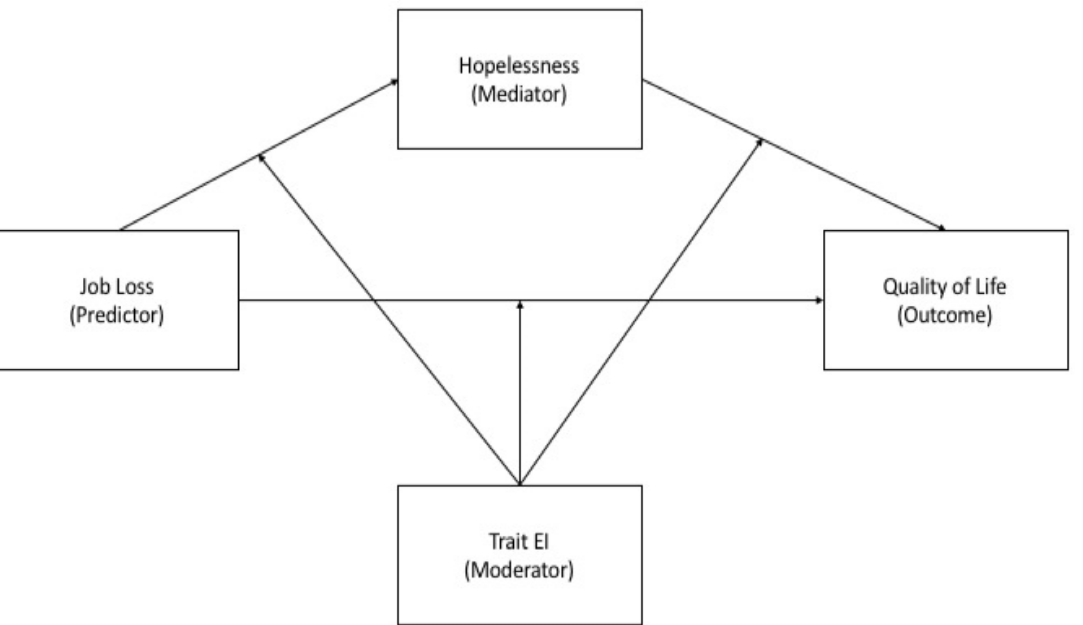
Figure 1. Moderated mediation model of associations between job loss, trait EI, hopelessness and quality of life.